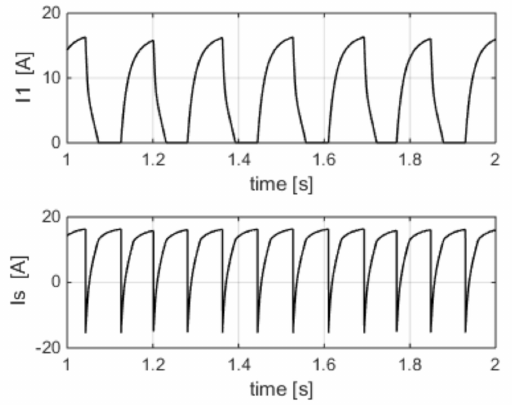
Figure 12. The waveforms of the current that flows through the upper coil (I 1 ) and the supply current (I s ).